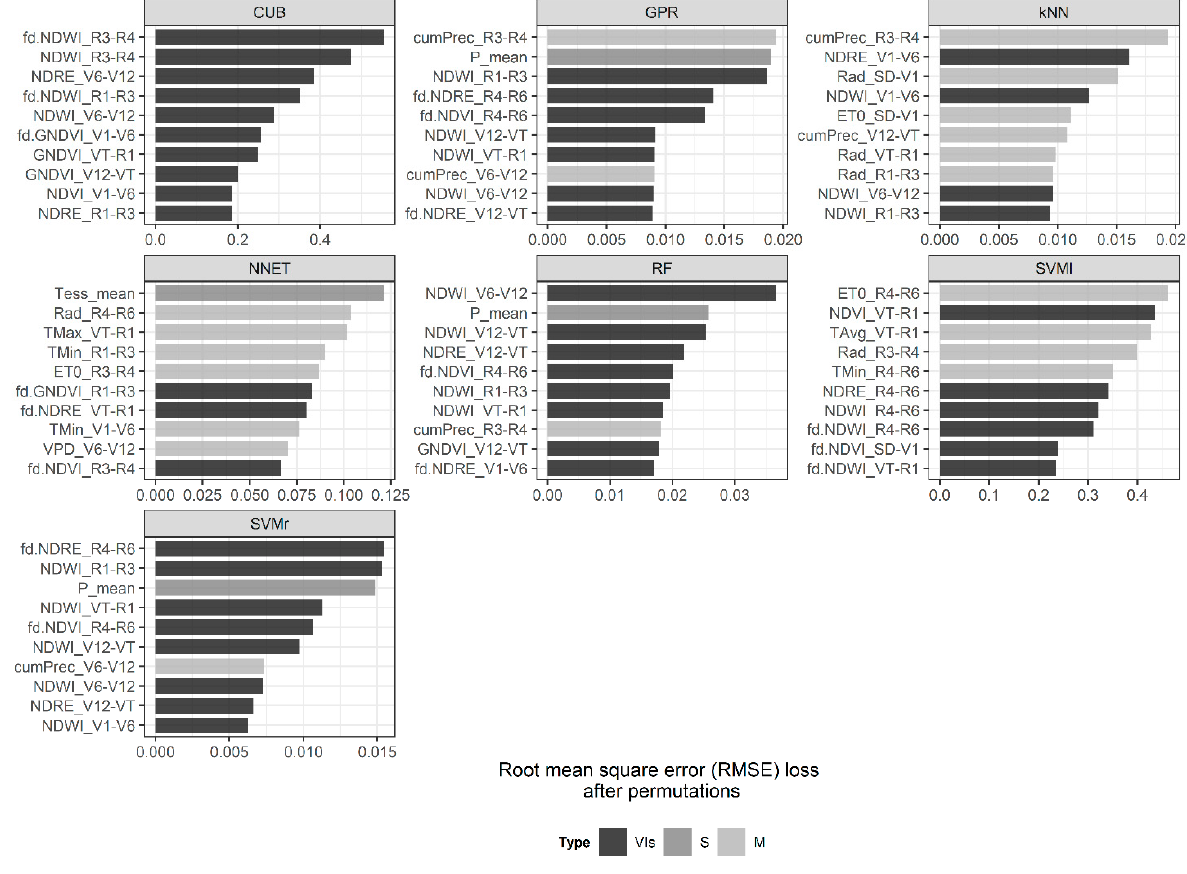
Figure 7. The variable importance of each ML algorithm (with the full feature set, VIs + S + M) for maize yield prediction at R6 (maturity stage) was expressed by the drop-out loss of model performance for each predictor related to the drop-out loss of the full model. The acronym “fd._” indicates the growth rate of a specific vegetation index in a specific phenological stage.